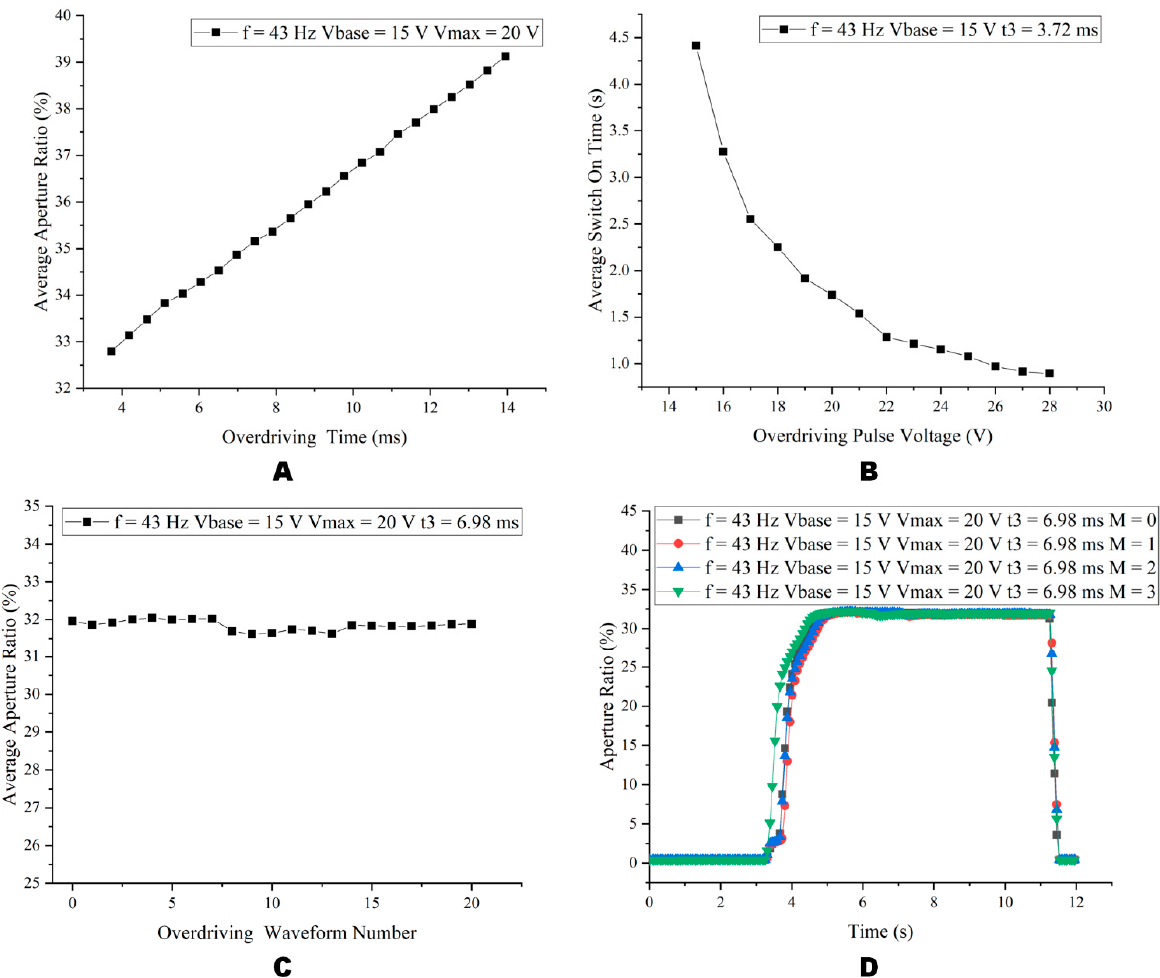
Figure 12. Influence of parameters of the overdriving waveform on the aperture ratio. ( A ) When f = 43 Hz, V base = 15 V, V max = 20 V, the relationship between t 3 and aperture ratio. ( B ) When f = 43 Hz, V base = 15 V, t 3 = 3.72 ms, the relationship between V max and average switch on time. ( C ) When f = 43 Hz, V base = 15 V, V max = 20 V, t 3 = 3.72 ms, the relationship between M and aperture ratio. ( D ) When f = 43 Hz, V base = 15 V, V max = 20 V, t 3 = 6.98 ms, the relationship between time and aperture ratio for different numbers of waveforms.